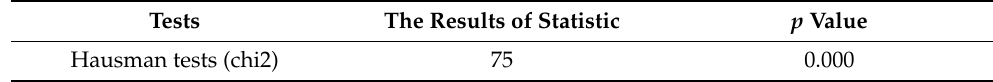
Table 2. Hausman test results summary.